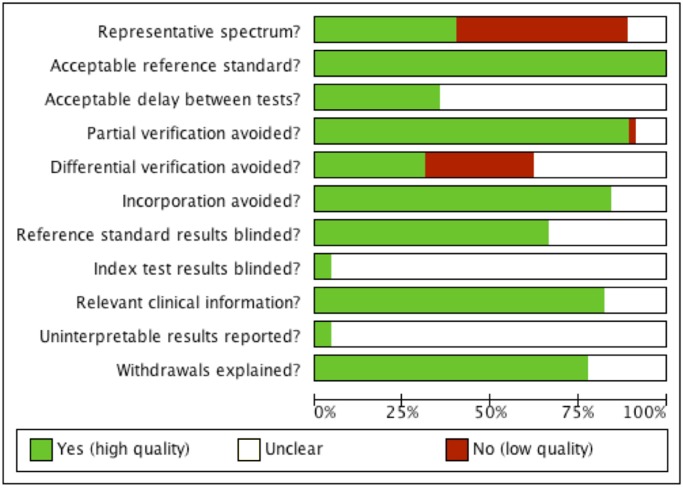
Methodological quality graph.Our judgements for each methodological quality item are presented as percentages for all included studies.